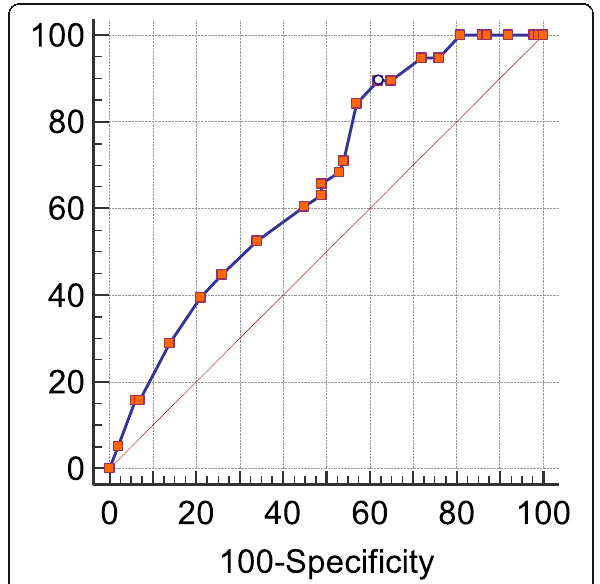
Fig. 3 Receiver operator characteristics (ROC) analysis showed that vitamin D serum level ≤ 9 ng/ml best predict stroke severity (as determined by NIHSS score) with sensitivity and specificity of 74.2% and 71%, respectively. Area under curve (AUC) of 77% was significantly different from the random 50% ( p < 0.0001)